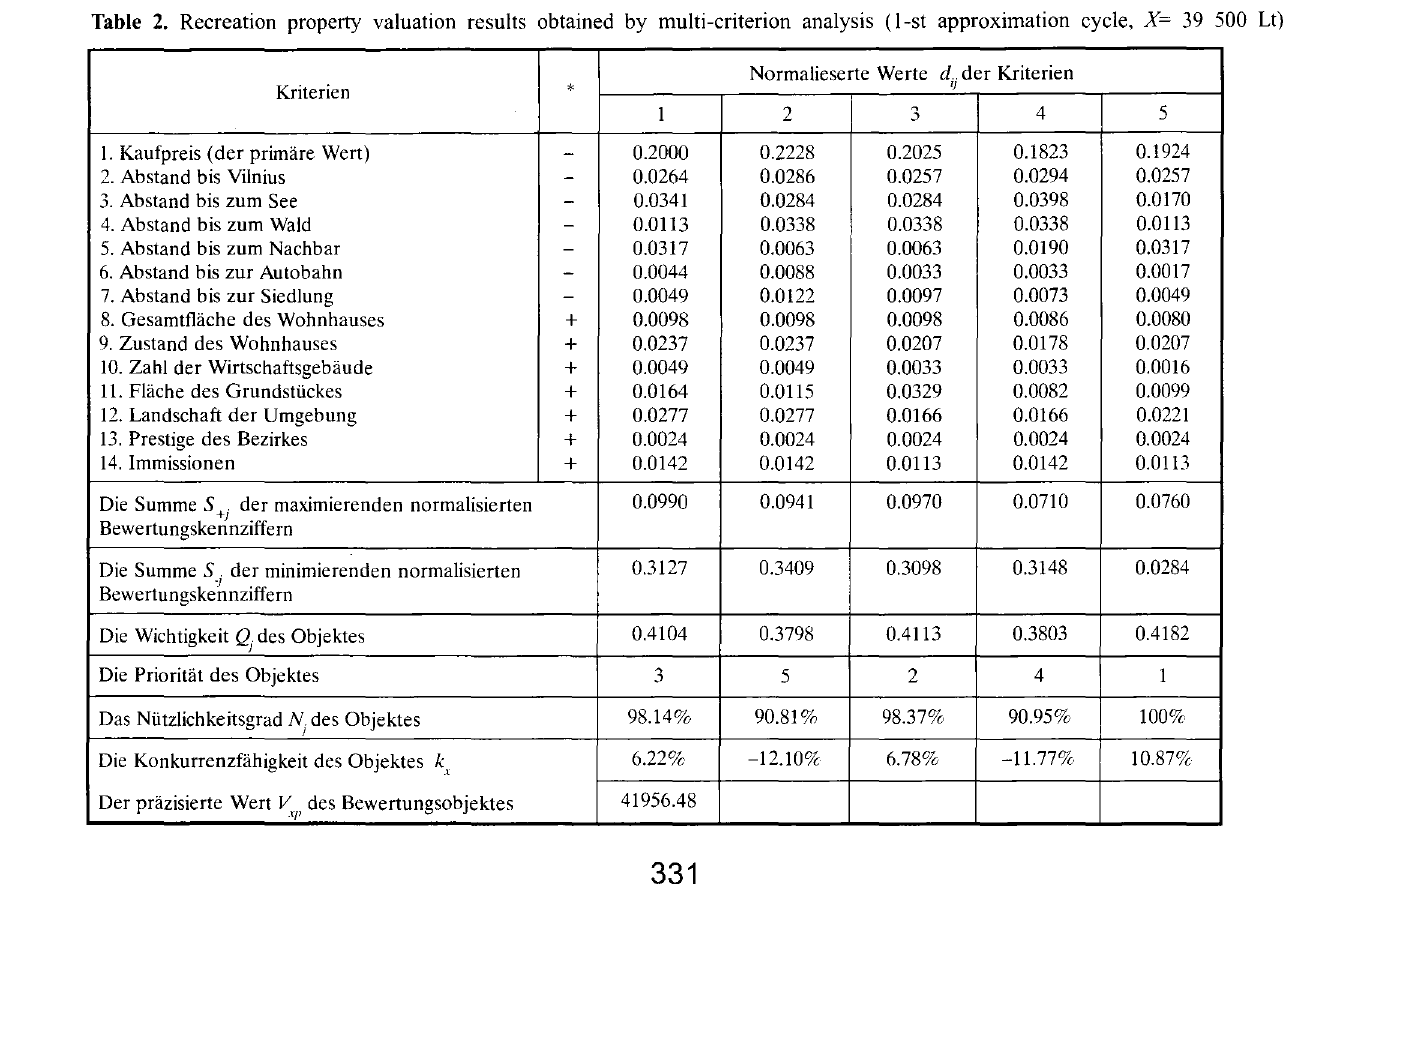
Table 2. Recreation property valuation results obtained by multi-criterion analysis (1-st approximation cycle, X= 39 500 Lt)